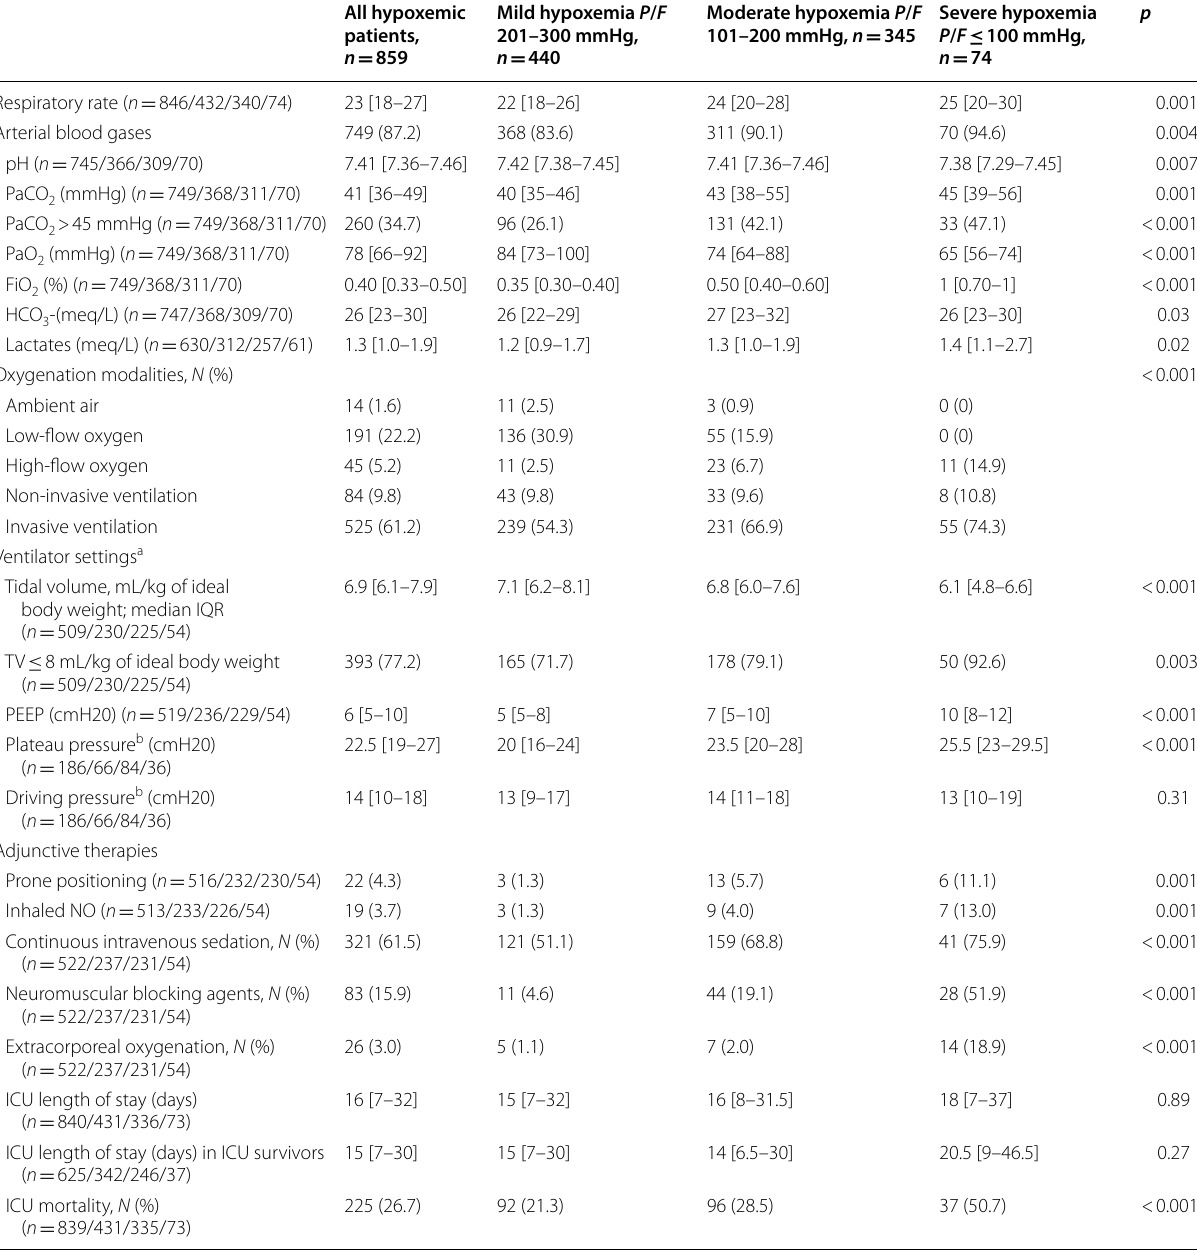
Table 3 Respiratory conditions and outcome according to severity of hypoxemia All hypoxemic